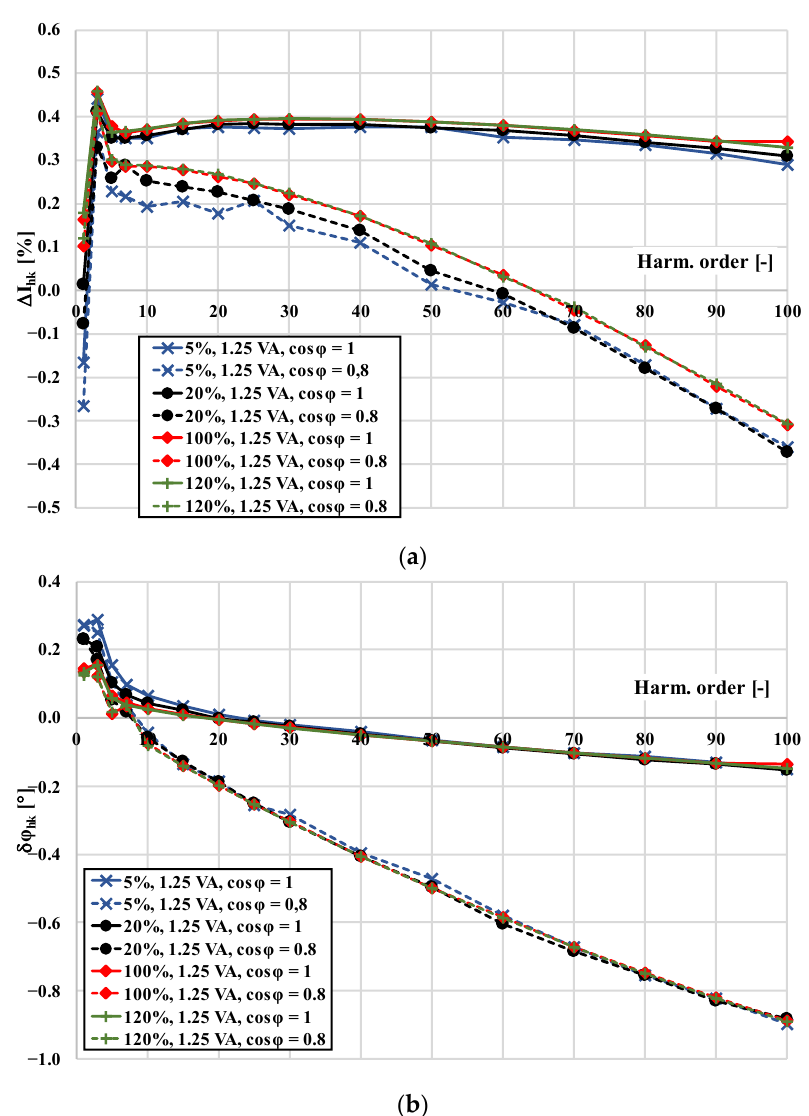
Figure 5. Comparison of the influence of the secondary winding of 25% of the rated load with power factor 0.8 inductive and 1.0 of a 300 A/5 A CT on: ( a ) current error; ( b ) phase displacement.